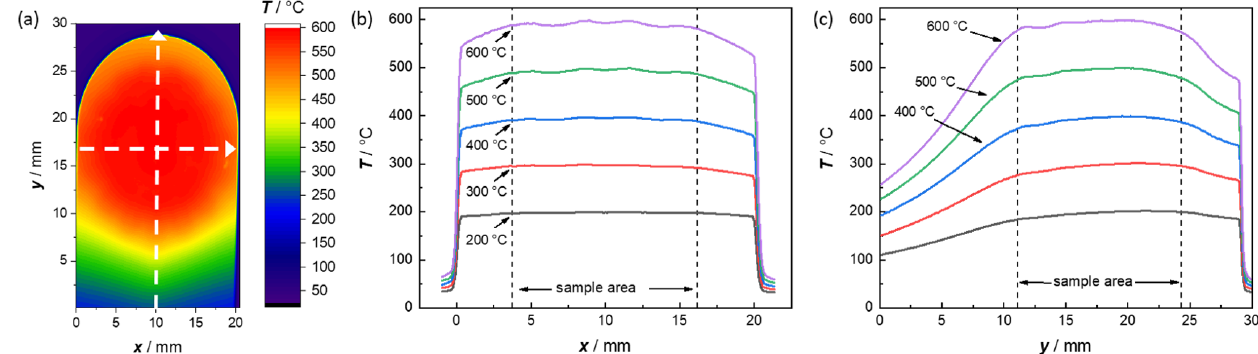
Figure 5. Thermal image of the sample area at 600 ◦ C. (a) Homogeneous temperature distribution within the sample area (b) Temperature profile along the x axis. (c) Temperature profile along the y axis through the center of the sample area.